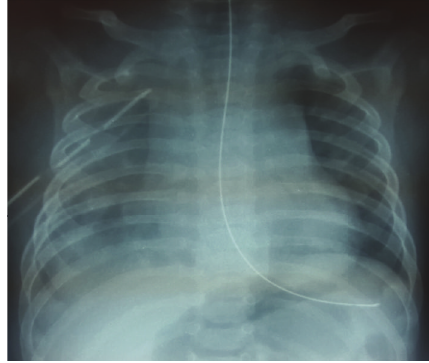
Figure 3: Chest X-ray after chest drainage.